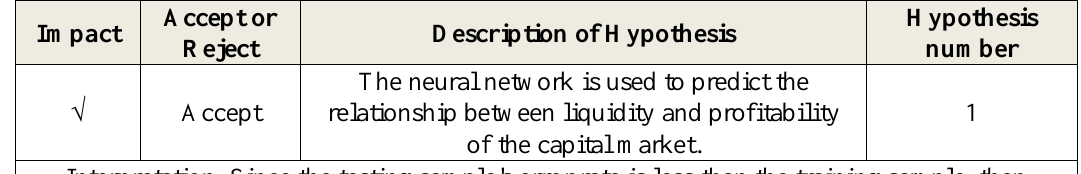
Table 17. Summary of the results of research